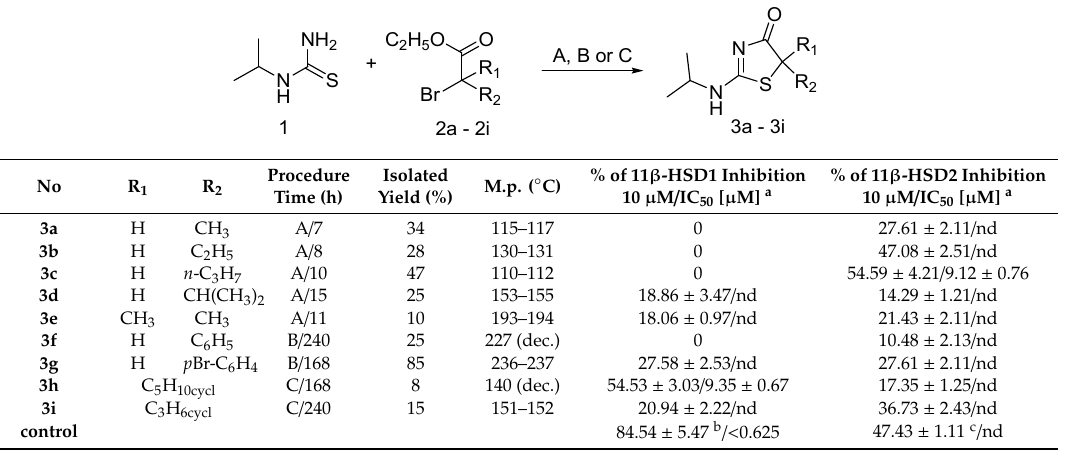
Table 1. Synthesis and inhibitory activity of 2-(isopropylamino)thiazol-4(5 H )-one derivatives.